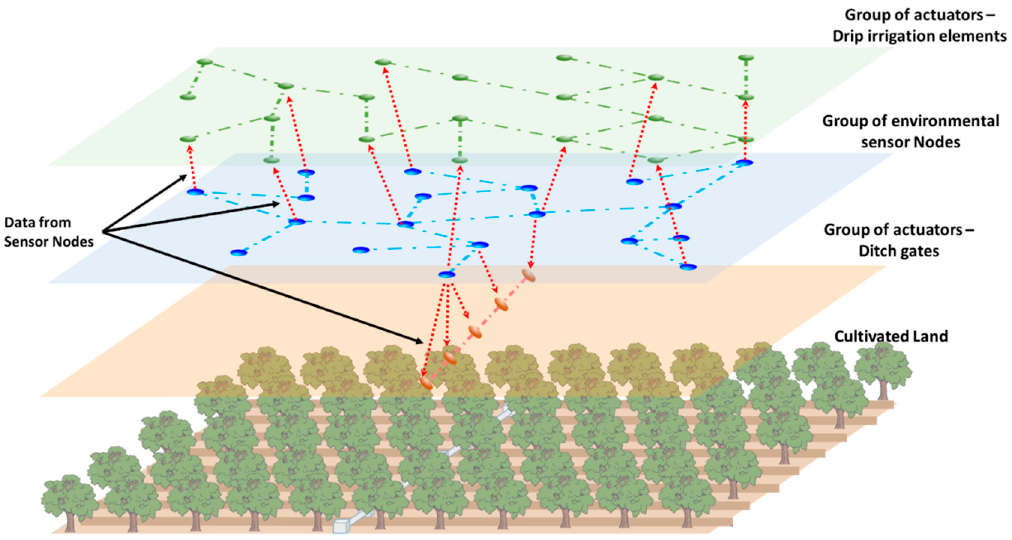
Figure 1. Proposed group-based network.